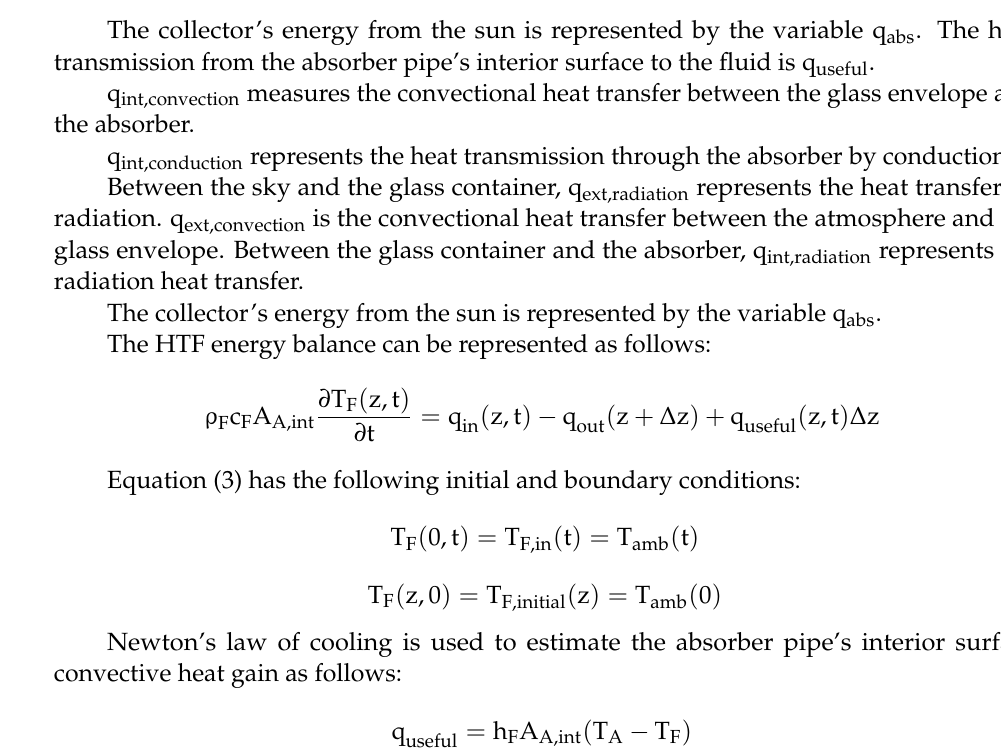
Figure 2. The PTC surface element thermal balance.